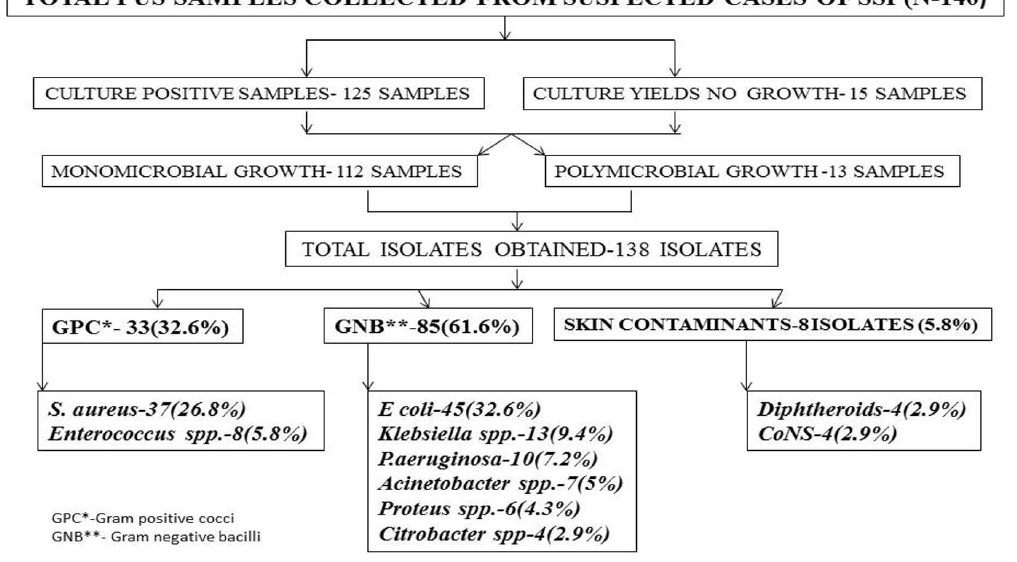
Fig. 1. Bacterial culture of the pus samples from surgical site